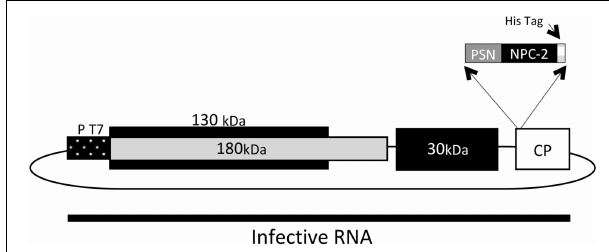
FIGURE 1 | Schematic diagram of the expression vector TMV-PSN-NPC-2 DNA. The coding sequence of SARSCoV-2 Nucleoprotein (NPC-2) was modified by the addition of C-terminal His tag and inserted into the TMV vector. An 82 bp fragment corresponding to the signal peptide (PSN) was included in position N-terminal. Infectious cDNA clone was transcribed from the T7 bacteriophage RNA promoter (PT7), and the RNA used to infect N. benthamiana plants. The TMV genome has four open reading frames (ORF). ORF 1 of 130 kDa with Methyltransferase and Helicase function, ORF 2 of 180 kDa with Methyltransferase, Helicase function and RNA-dependent RNA polymerase (RdRp) function. ORF 3 of 30 kDa corresponding to Movement Protein (MP) and ORF 4 of 17 kDa corresponding to Coat Protein (CP).